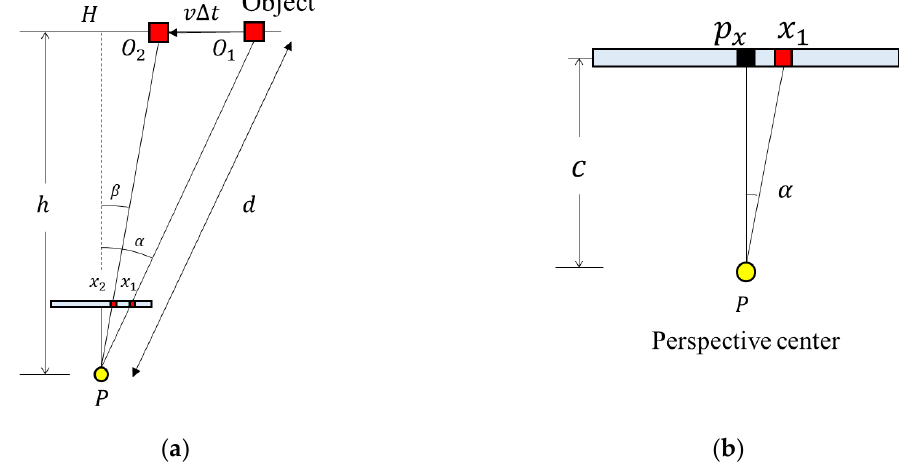
Figure 7. Bird’s-eye view of the RSE occurrence: ( a ) relationship between the vertical distance and the distance and ( b ) angle between the pixel, the perspective center, and the principal point .